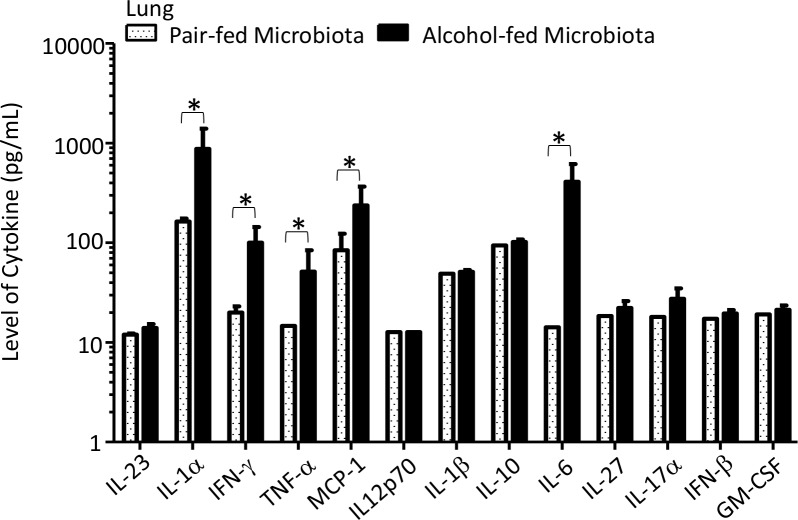
Alcohol-associated dysbiosis alters acute pulmonary inflammatory cytokines.Levels of pulmonary acute inflammatory cytokines were asssesed 48 hrs. post-Klebsiella infection via LEGENDplex 13-ples assay kit. Bars represent the mean cytokine level ± SEM, * indicates P < 0.05, by ANOVA with Dunn’s correction. N = 10/group.